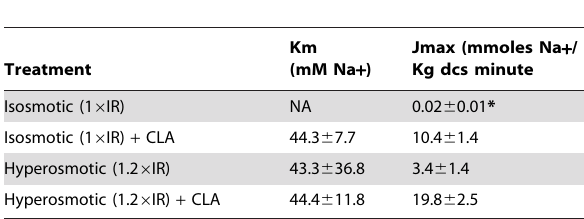
Table 2. Na + transport kinetic constants for NHE1 in Amphiuma RBCs stimulated to steady-state in isosmotic solution with 500 nM CLA, or mildly hyperosmotic (1.2 6 IR) solution 6 CLA.